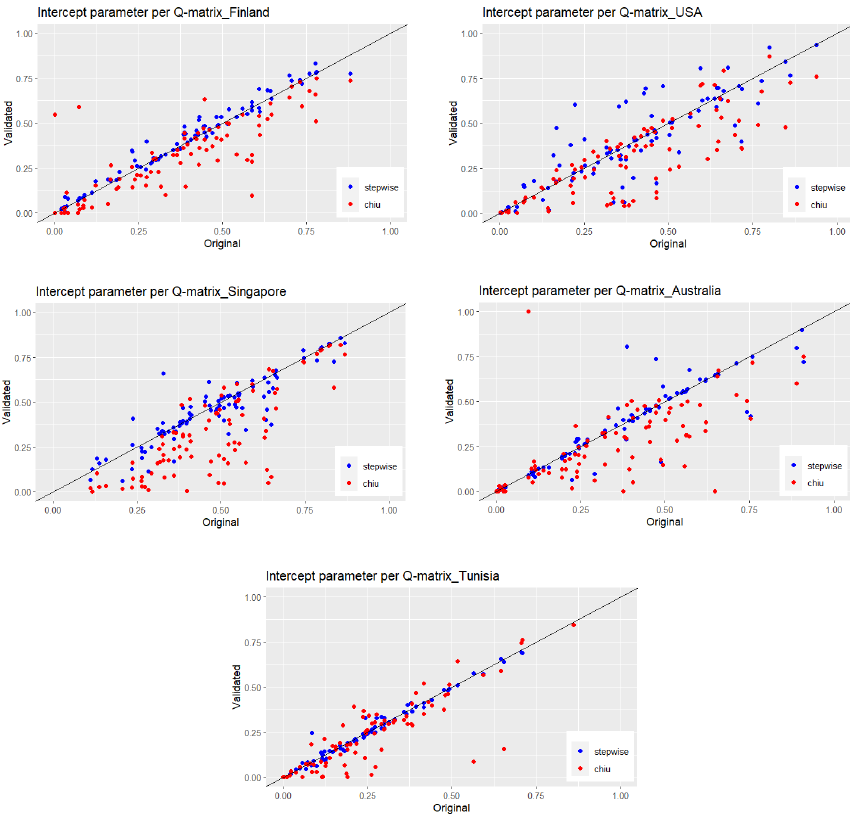
Fig. 2 Intercept Parameters per item for the four G-DINA models per